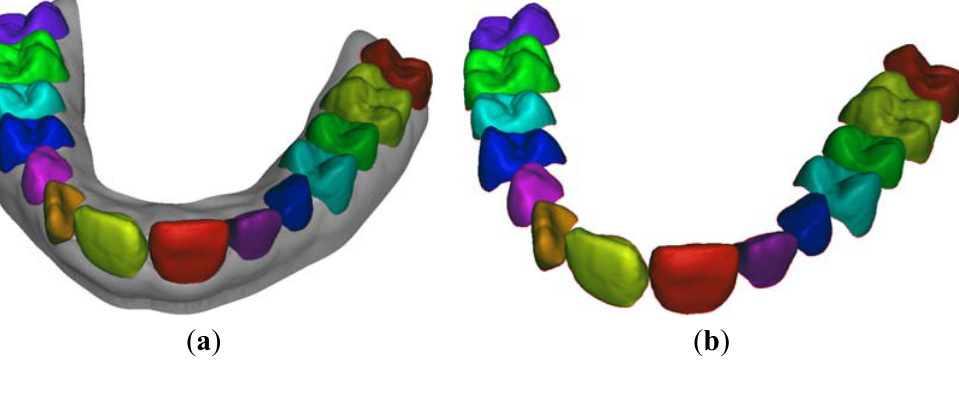
Figure 7. ( a ) Segmented digital merged model and ( b ) relative optically-scanned crown